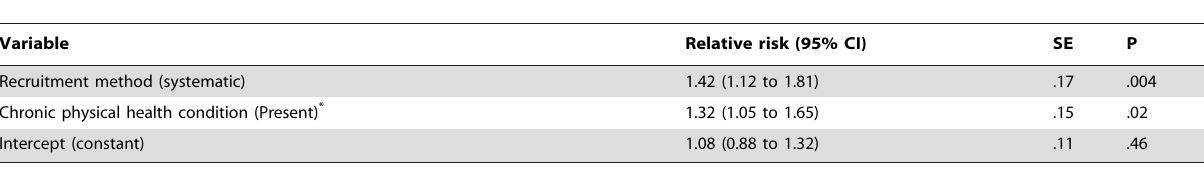
Table 7. Multivariable predictors of antidepressant use (N